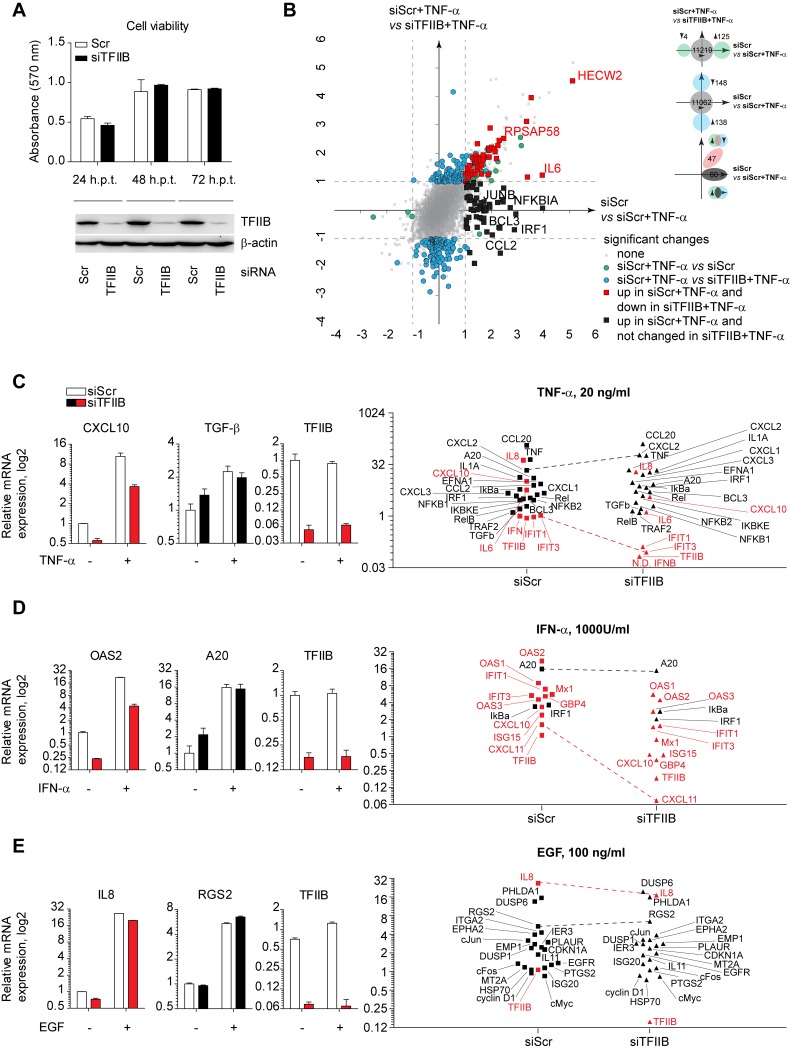
TFIIB depletion preferentially affects a subset of inflammatory cytokines and antiviral effector genes.A) Viability of HeLa cells after TFIIB knockdown at indicated time points. HeLa cells were treated with indicated siRNAs for 24, 48 and 72 hours and knockdown was validated by Western blot analysis. Cell viability was assessed by MTT assay. The bar graph shows mean and SD of three technical replicates and is a representative of two independent experiments with similar results. B) 2D-scatter plot of transcriptome analysis of HeLa cells before and after TFIIB knockdown mock-treated or stimulated with TNF-α in three biological replicates. HeLa cells were electroporated with Scrambled or TFIIB-targeting siRNAs. In 24 hours they were left untreated or stimulated with TNF-α (20 ng/ml) for 2 hours. Total RNA was extracted and analysed by RNA-seq. X axis shows log2 fold changes between mock-treated and TNF-α-treated cells with non-targeting siRNA (green dots), Y axis represents log2 fold changes between TNF-α-treated Scrambled-transfected cells and TNF-treated siTFIIB-transfected cells (blue dots). Genes upregulated by TNF-α in non-targeted cells and downregulated by TFIIB knockdown are shown in red. Genes upregulated by TNF-α in non-targeted cells and not regulated by TFIIB knockdown are shown in black. Numbers are shown in the scheme. Differentially regulated genes were showing at least 2-fold change with a q value < 0.05. C) qPCR analysis of genes regulated by TNF-α stimulation and affected (red) or non-affected (black) by TFIIB knockdown in HeLa cells. Bar graphs show representative genes. Scatter plots show all genes analysed. Dashed lines are showing the direction of change for affected (red) and non-affected (black) genes. Log2 fold changes are shown relative to Scrambled-transfected mock-treated cells. D) qPCR analysis of genes regulated by IFN-α stimulation. E) qPCR analysis of genes regulated by EGF stimulation. For all stimuli HeLa cells were electroporated with indicated siRNAs and in 16 hours stimulated with indicated ligands for 4 hours with subsequent RNA extraction. qPCR analysis was performed in two technical replicates in two independent experiments.